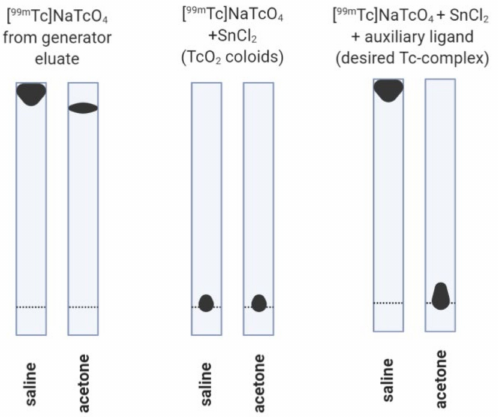
Figure 2. Schematic results of TLC analysis developed in saline (aqueous) and acetone (organic) mobile phases of free [ 99m Tc]NaTcO 4 (left two strips), reduced pertechnetate in form of [ 99m Tc]TcO 2 (middle two strips) or 99m Tc-complex of molecule that are able to directly chelate reduced 99m Tc cations (right two